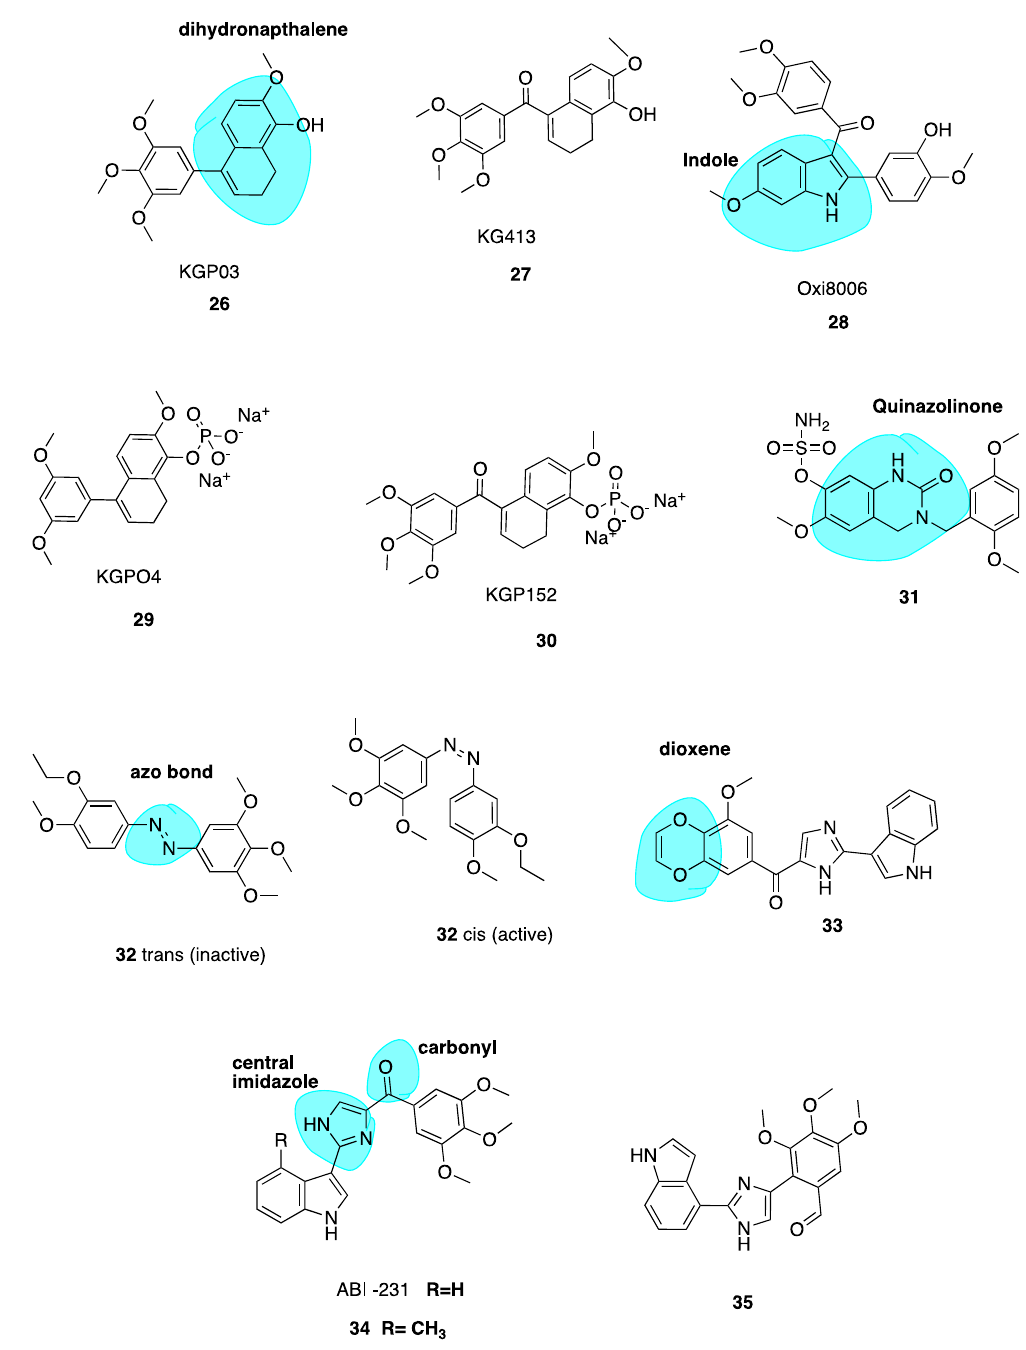
Figure 6. Structures of compounds 26 – 35 .